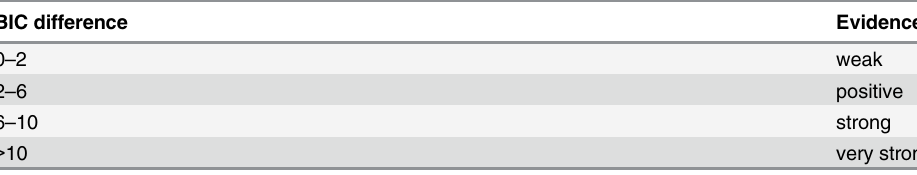
Table 2. Grade of evidence of the BIC difference